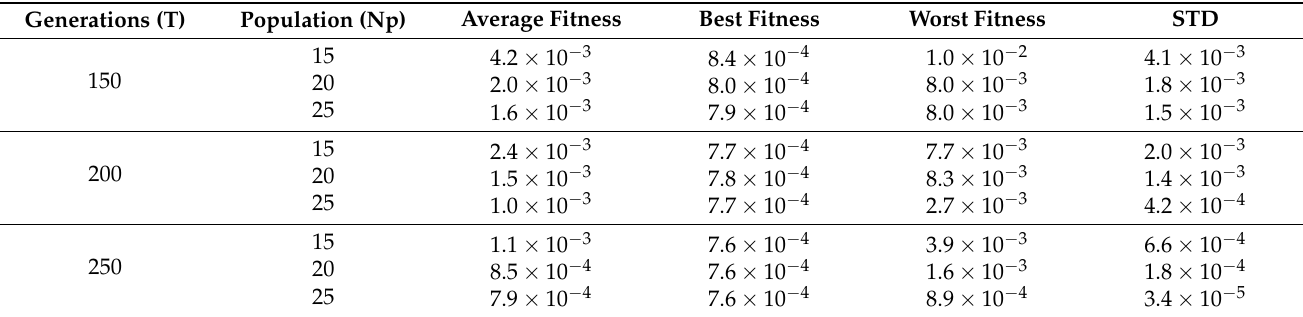
Table 3. DMOA analysis w.r.t. generation numbers and population sizes at 0.03 noise